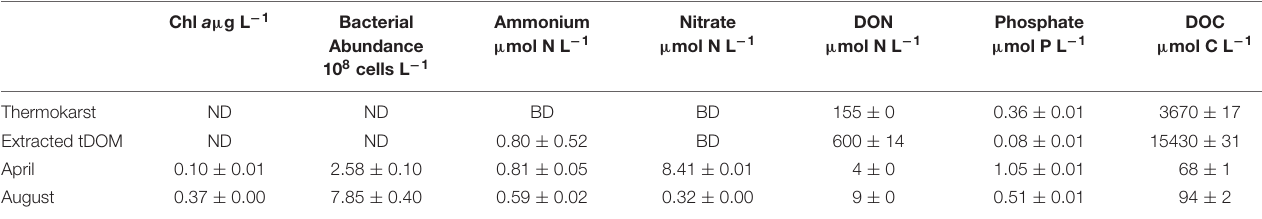
TABLE 2 | Biological and chemical concentrations in the tDOM source and ambient site